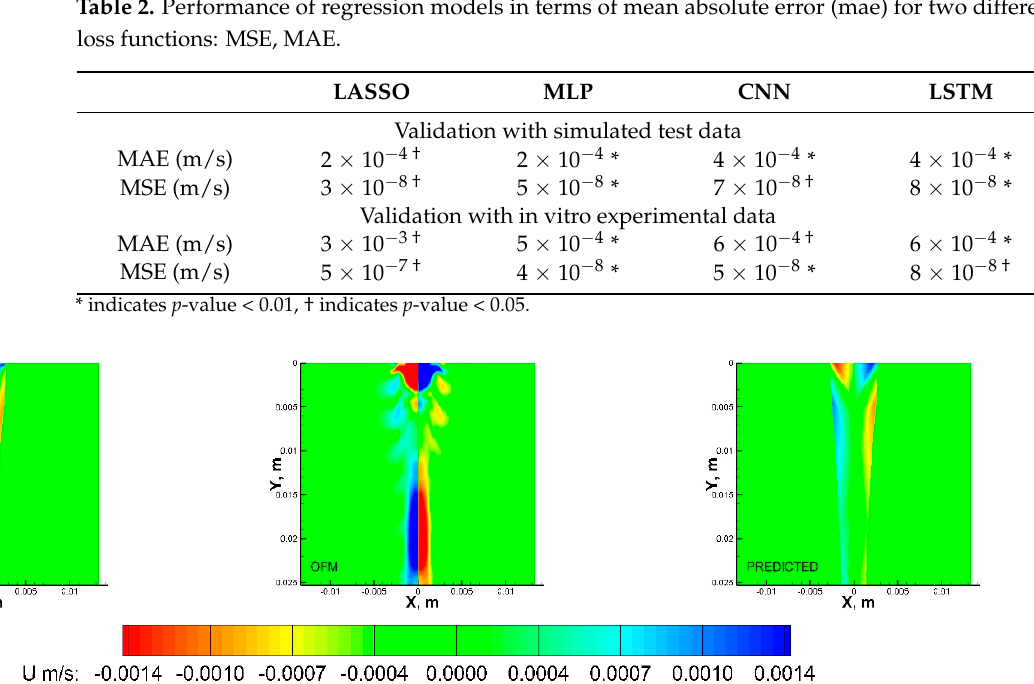
Figure 7. U − contours of the CFD ground truth ( left ), OFM ( middle ), and predicted ( right ) results.